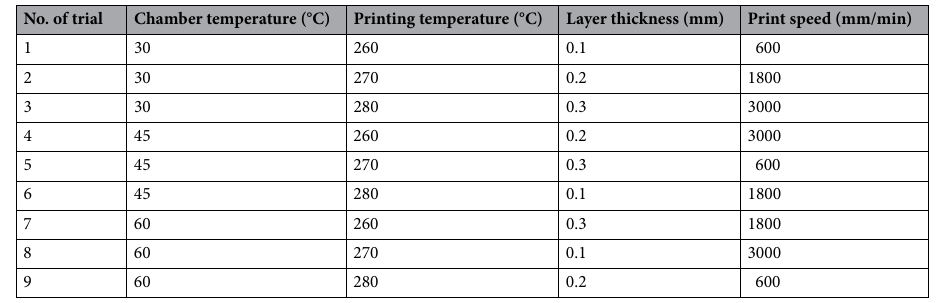
Table 3. L9 orthogonal array.